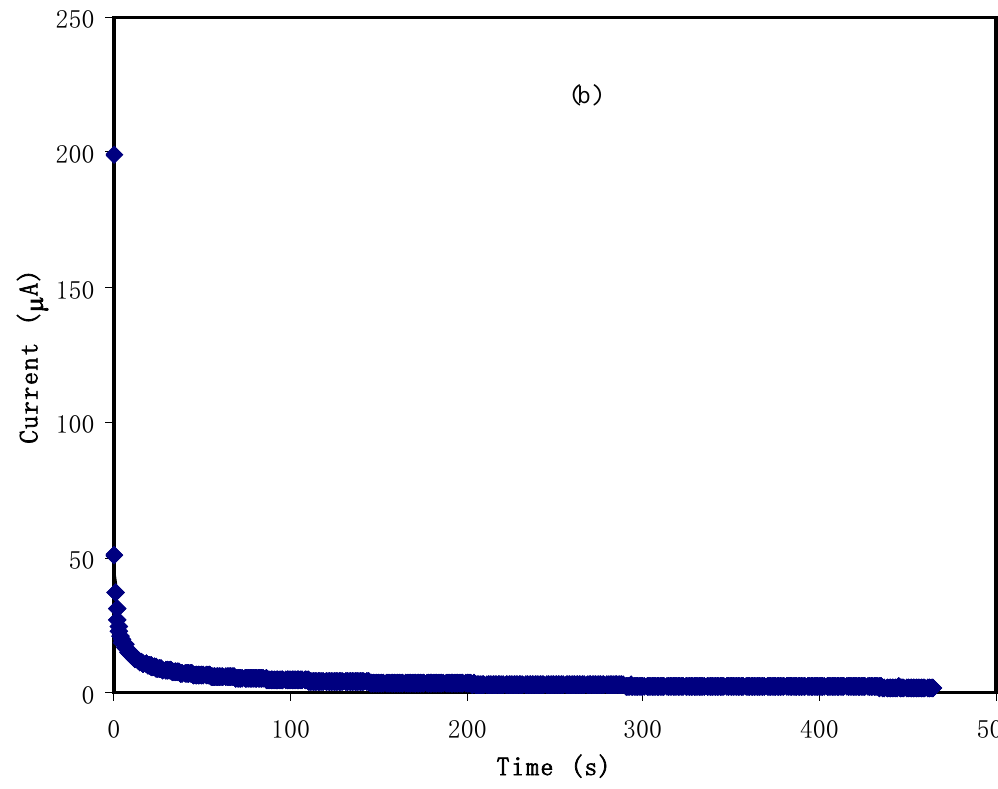
Figure 4. Current against time for the ( a ) PVCH2, and ( b ) PVCH3 electrolyte films.